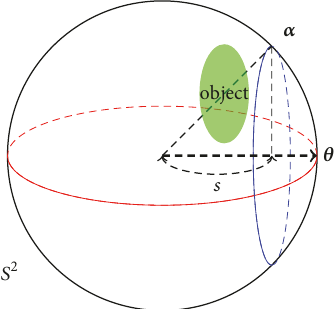
Figure 1: The circle on the sphere in the plane perpendicular to ( 𝜃 ,0) ∈ 𝑆 2 with distance 𝑠 from the origin.